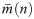
Reference distance soft constraints.The green intensity colormap indicates the probability of presence for the recovered frame. If the recovered frame m¯(n) is outside the confidence zone (delimited by spheres of radii r1 and R1), it is projected onto the closest point in this confidence zone (m^(n)).